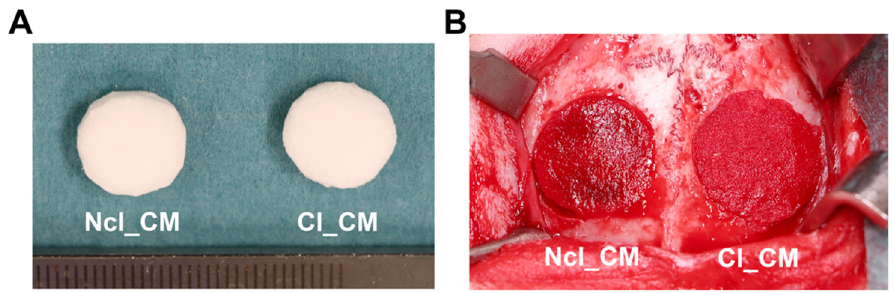
Figure 2. ( A ) Pre-shaped Ncl_CM ( left ) and Cl_CM ( right ) before the implantation ( φ = 10 mm, thickness = 3 mm). (B ) Image of the implanted CMs during surgery.